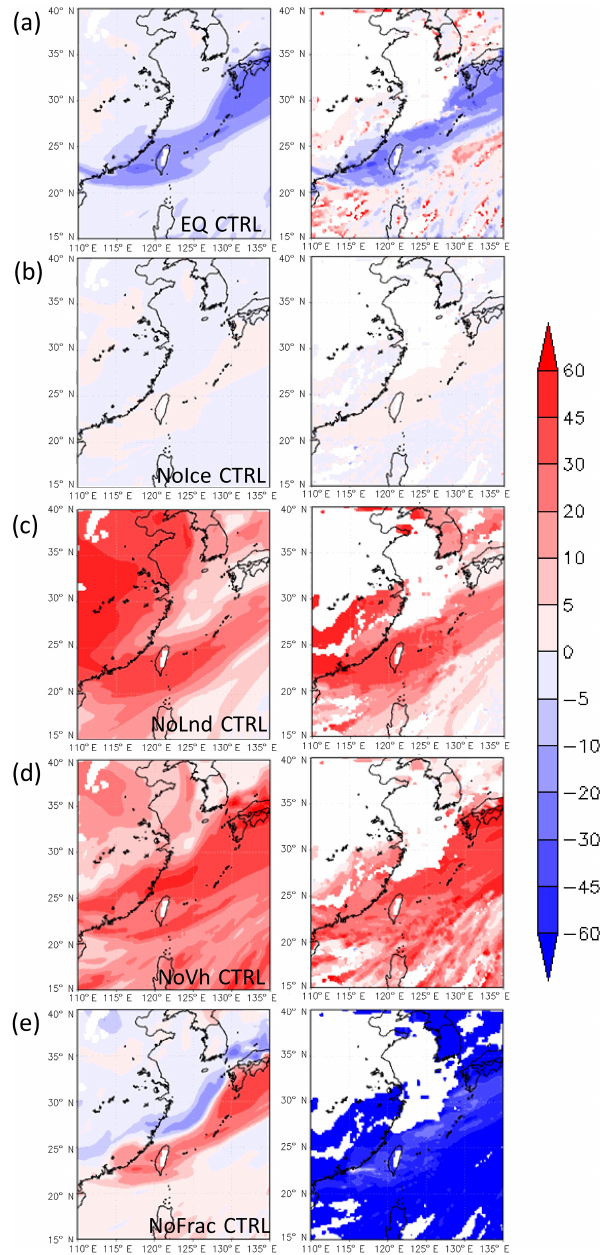
Figure 9. Difference in simulated δ D (in ‰) of water vapor (left panel) and liquid-phase condensates, including clouds and rainwa- ter (right panel), between CTRL and other runs: (a) EQ CTRL, (b) NoIce CTRL, (c) NoLnd CTRL, and (d) NoVh CTRL, and (e) NoFrac CTRL, at 850hPa on 12 June 2012.